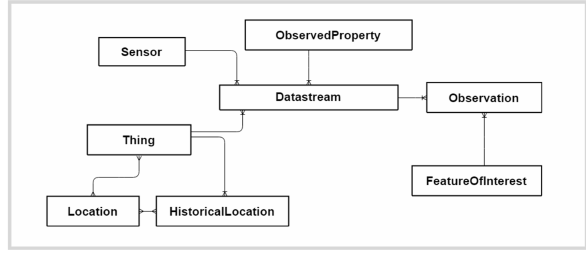
Figure 3. The simplified data model of the